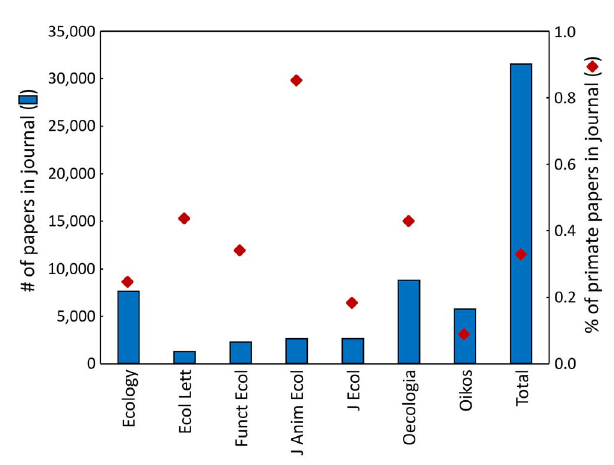
Figure 2. Total number of papers published in different ecological journals and percentage of these papers that relate to primates. Ecol Lett = Ecology Letters, Funct Ecol = Functional Ecology, J Anim Ecol = Journal of Animal Ecology, J Ecol = Journal of Ecology.